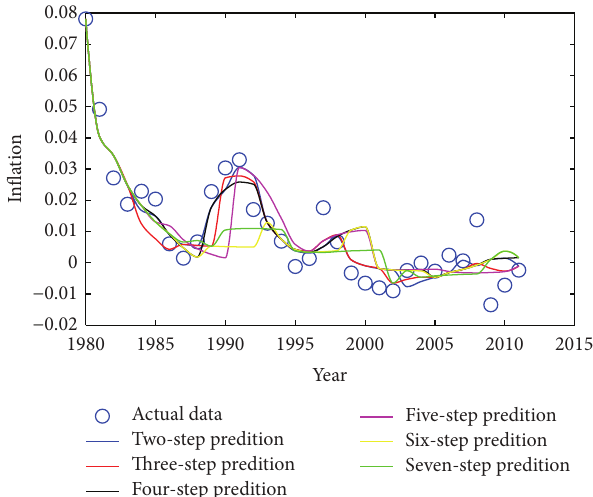
Figure 6: The predictions of inflation based on empirical model in the case of Δ𝑡 = 1